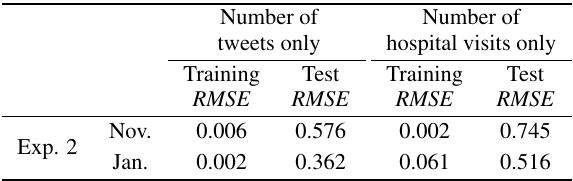
Table 20 Prediction evaluation using either tweet counts or counts of hospital